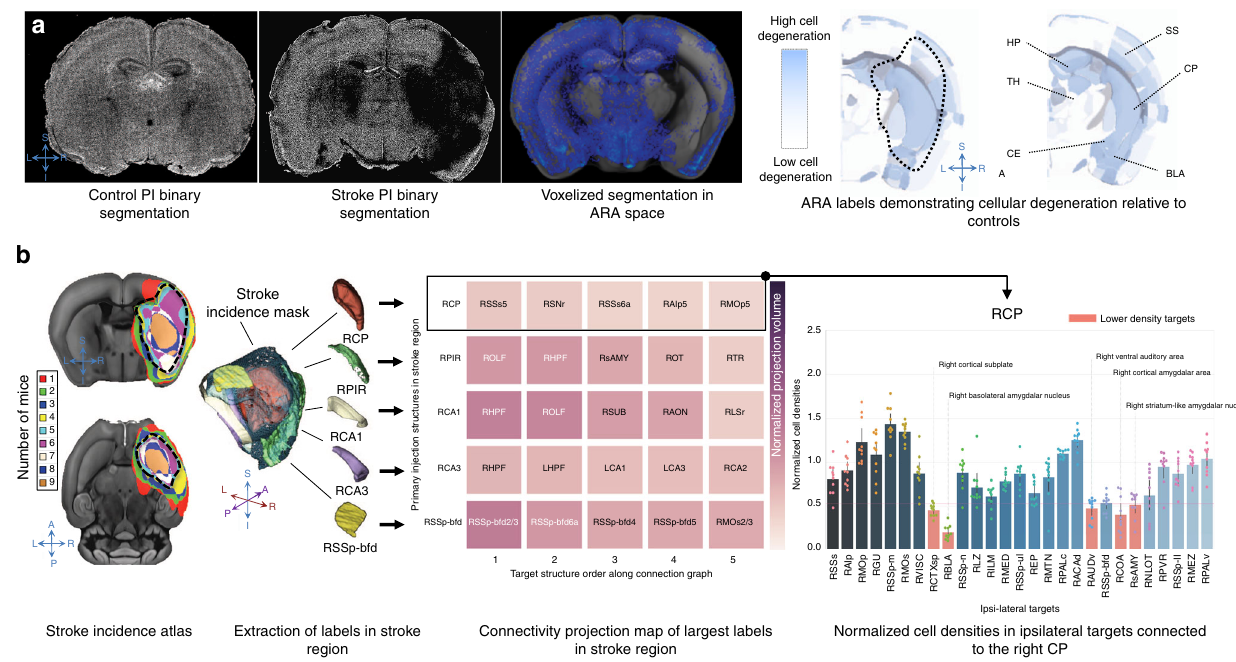
Fig. 4 Observed cellular degeneration in remote region at the acute stage. a Visualization of cellular degeneration (relative to controls) due to stroke in ARA labels. From left to right: Binary PI segmentation of a control mouse (coronal view) showing similar nuclei counts across both hemispheres. Binary PI segmentation of a stroke mouse showing diminished cellularity in the infarct. The voxelized map (in blue, downsampled and registered to the ARA template in grayscale) also shows diminished cell density per voxel. Right: Two coronal slices of the ARA atlas with label intensity representing decreased cell density normalized to control mice. The dotted line approximately outlines the stroke region with a 50% incidence across the stroke cohort. Lower opacity corresponds to a decrease in cell density. SS: somatosensory areas, CP: caudoputamen, TH: thalamus, HP: hippocampus, CEA: central amygdalar nucleus, BLA: basolateral amygdalar nucleus, S – I: superior – inferior, R – L: right – left. b Investigation of cellular changes in the connected regions. Left: stroke incidence map demonstrating the incidence of an ARA voxel being present in the stroke cohort, with the black dashed line outlining an incidence of >50%. Center left: Rendering of the 50% stroke incidence mask depicting the largest fi ve ARA labels in that mask (RCP: right caudoputamen, RPIR: right piriform area, RCA1: fi eld CA1 of the right hippocampus, RCA3: fi eld CA3 of the right hippocampus, RSSp-bfd: right primary somatosensory area, barrel fi eld). Center right: projection targets of each of the largest fi ve labels in the stroke mask (with each label as an injection sites), ranked by normalized projection volume (color bar). Right: The bar graphs represent PI cell density in our stroke mice normalized to controls. Salmon-colored bars indicate regions with cell densities lower than two standard deviations from the mean of all normalized regions. The strength of connectivity decreases from left to right and with increasing color brightness, with the most connected regions being darker and on the left. Individual data points for each target region are overlaid on its corresponding bar graph. Error bars represent 95% con fi dence intervals using 1000 bootstrap the injection site and its parent labels through interfacing with the Allen connectivity software, the pipeline automatically extracted the efferent targets from respective viral tracing experiments for the largest 50 ARA labels within the 50% incidence stroke mask (Fig. 4b, ≥ 5 affected mice, cyan mask with dotted black outline).